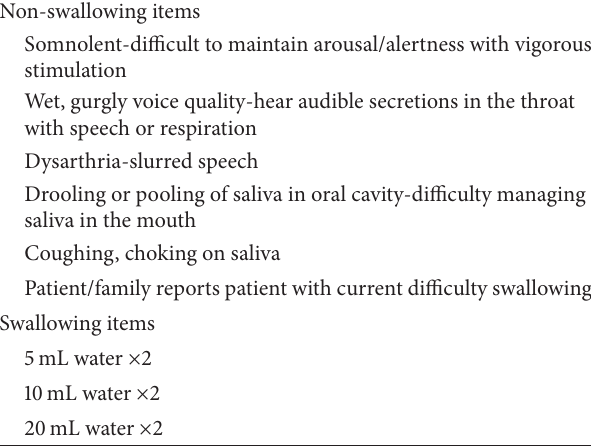
Table 1: Michael E. DeBakey Veterans Affairs Medical Center stroke swallowing screening